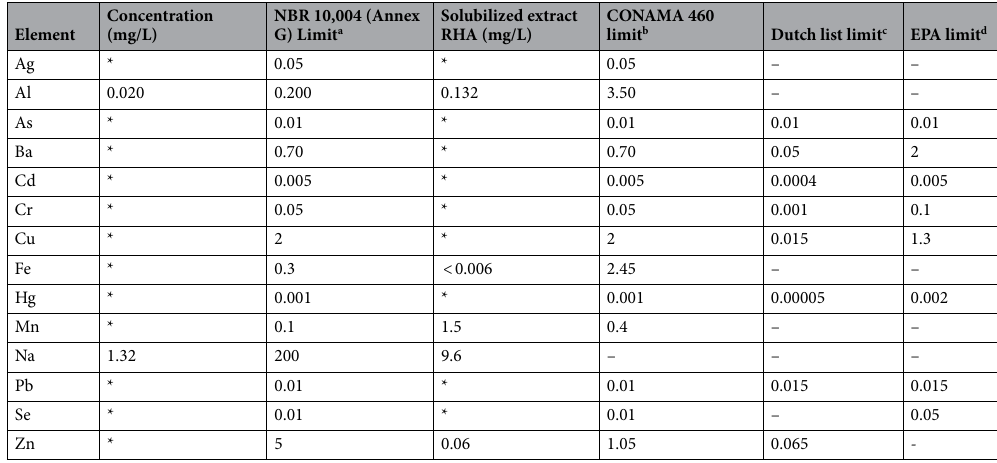
Table 6. Metal concentrations of mixture 1 after acidic attack. *Below detection limit; a solubilized contaminant contents; b guiding values of groundwater and drinking water; c target values of groundwater; d maximum contaminant levels—national primary drinking water